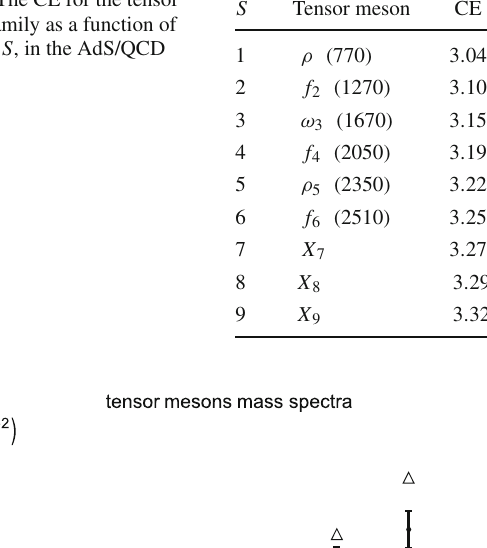
Table 2 The CE for the tensor mesons family as a function of their spin S , in the AdS/QCD model